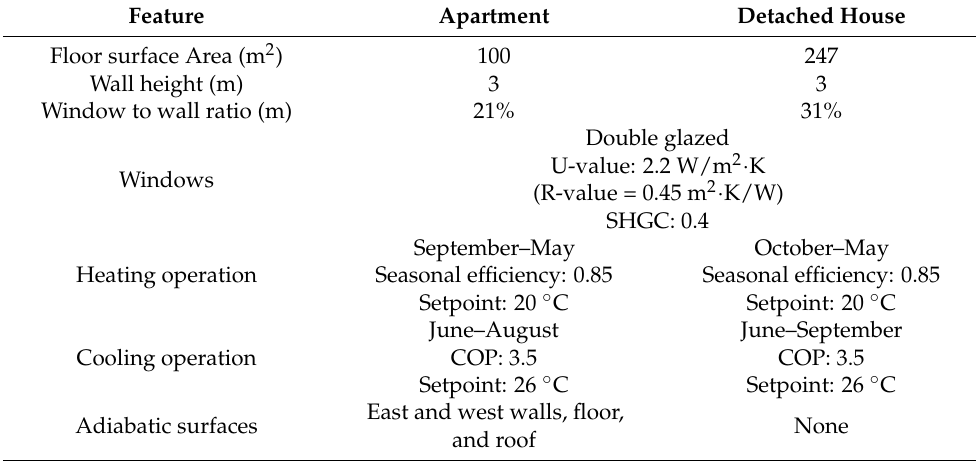
Table 1. Characteristics of the modeled apartment and detached house [24].